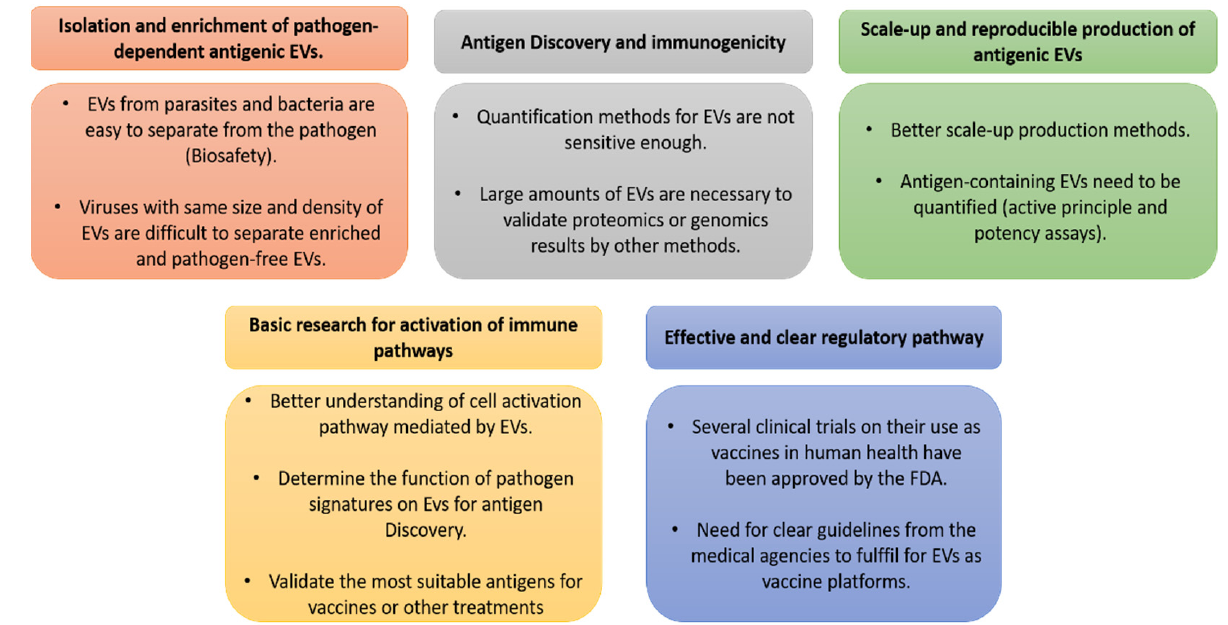
Figure 1. Key gaps in knowledge to be filled for the use of EVs as vaccines.